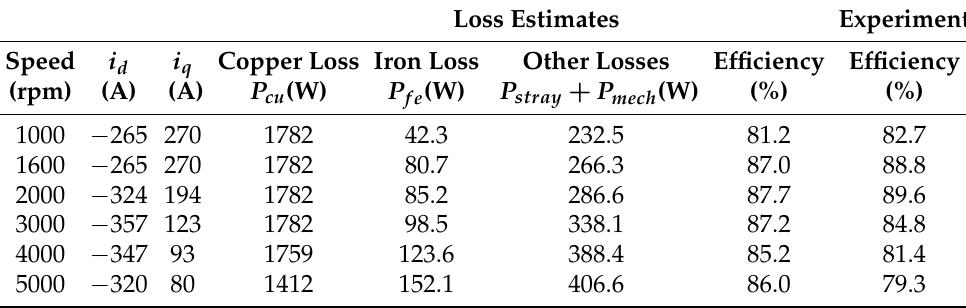
Table 2. Efficiency